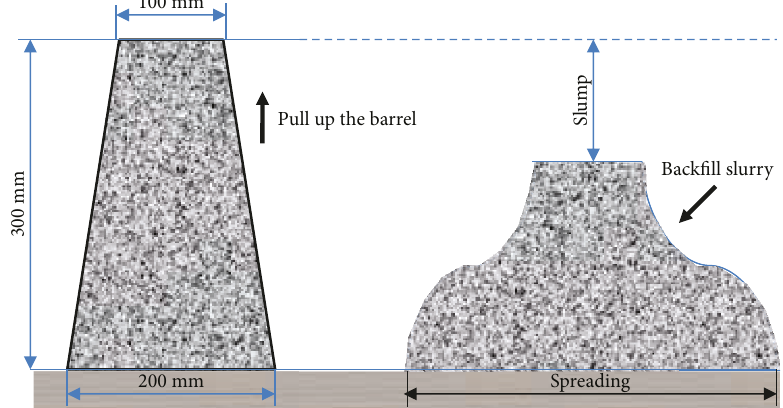
Figure 4: Schematic of the PGBS slump [22].